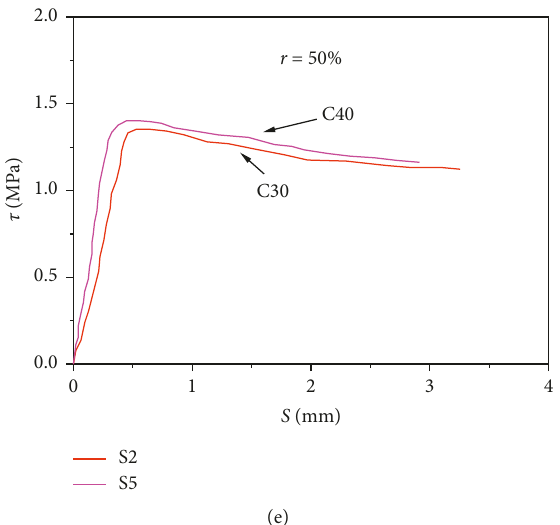
Figure 4: Typical bond stress-slip curves: effect of (a) temperature, (b) exposure time, (c) RCA replacement ratio, (d) interface length-to- width ratio, and (e) concrete strength.